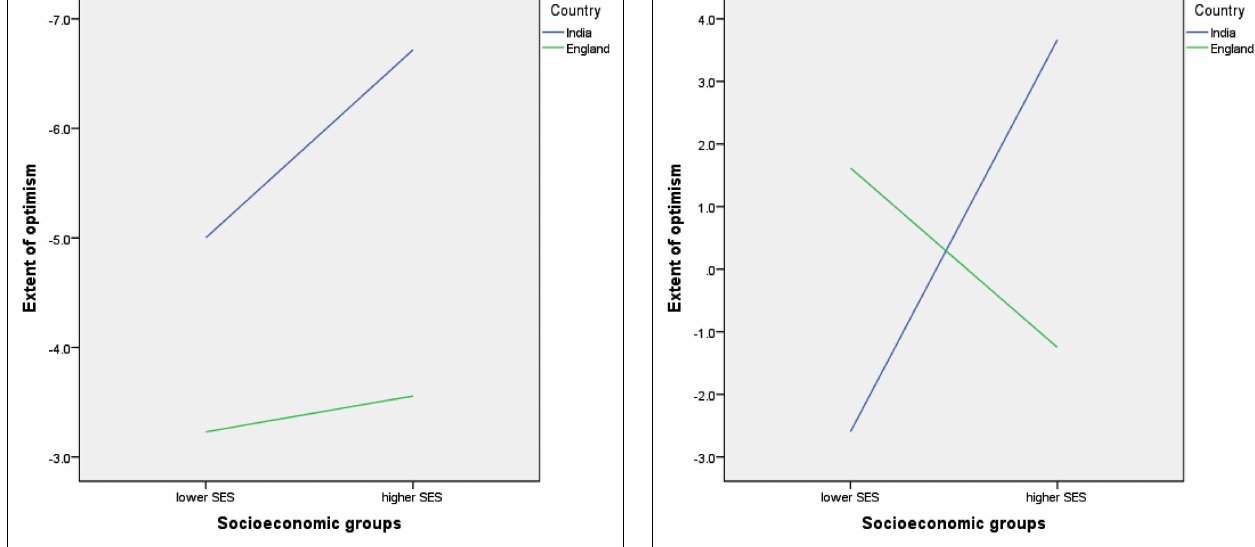
FIGURE 1 | Relative optimism for bad events. FIGURE 2 | Relative optimism/pessimism for good